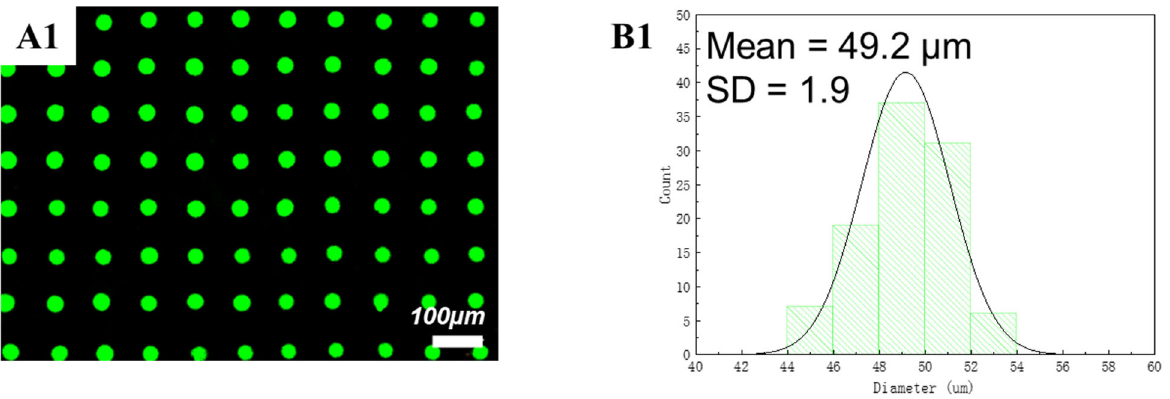
Figure 8. ( A1 ) The microscope image of the printed green QD-PDMS dot array on sapphire under 365 nm UV excitation. ( B1 ) Diameter distribution of the printed green QD-PDMS dot array (from array of 10 × 10) on sapphire. The standard deviation (SD) was less than 2.46 or approximately 5% of the mean.